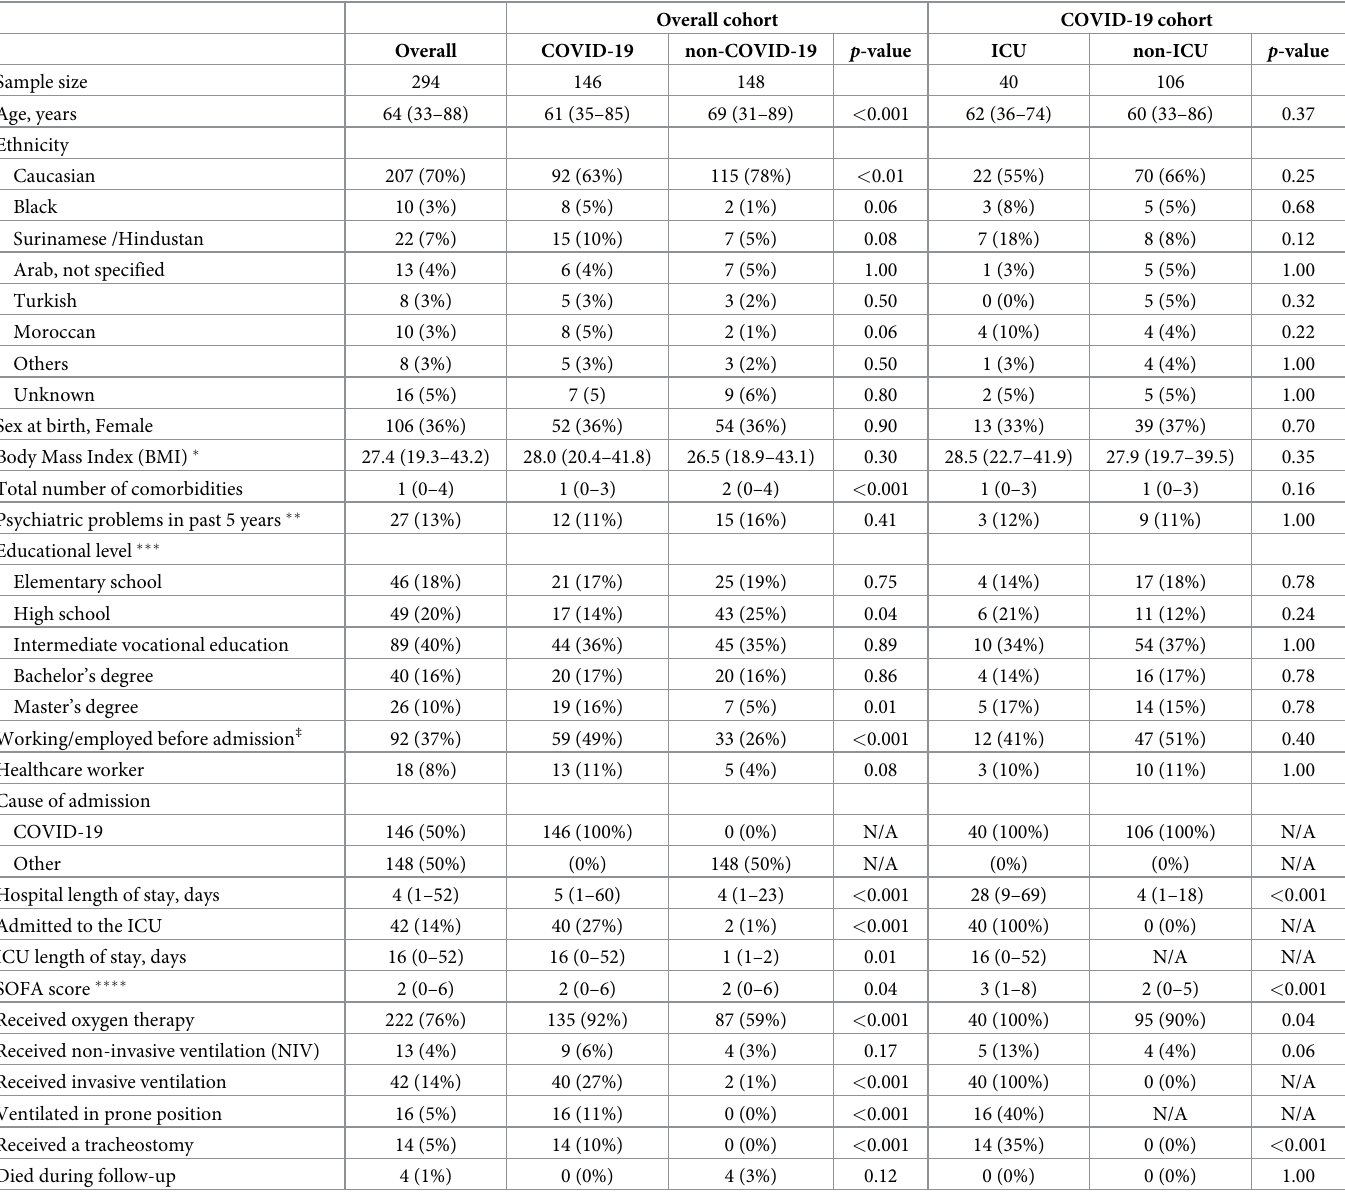
Table 1. Baseline demographics and treatment-related characteristics of study